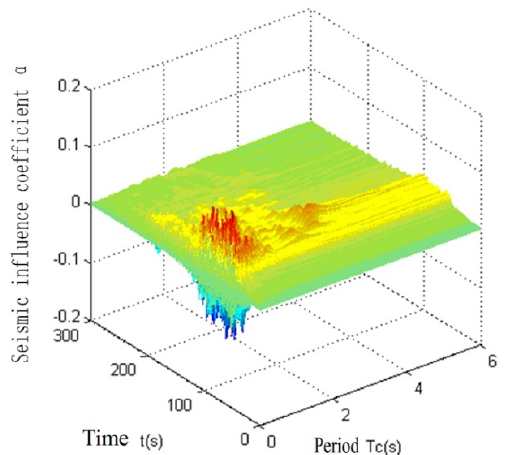
Figure 6. Time – domain curved surface of the seismic influence coefficient of acceleration (time interval of 0.01 s).